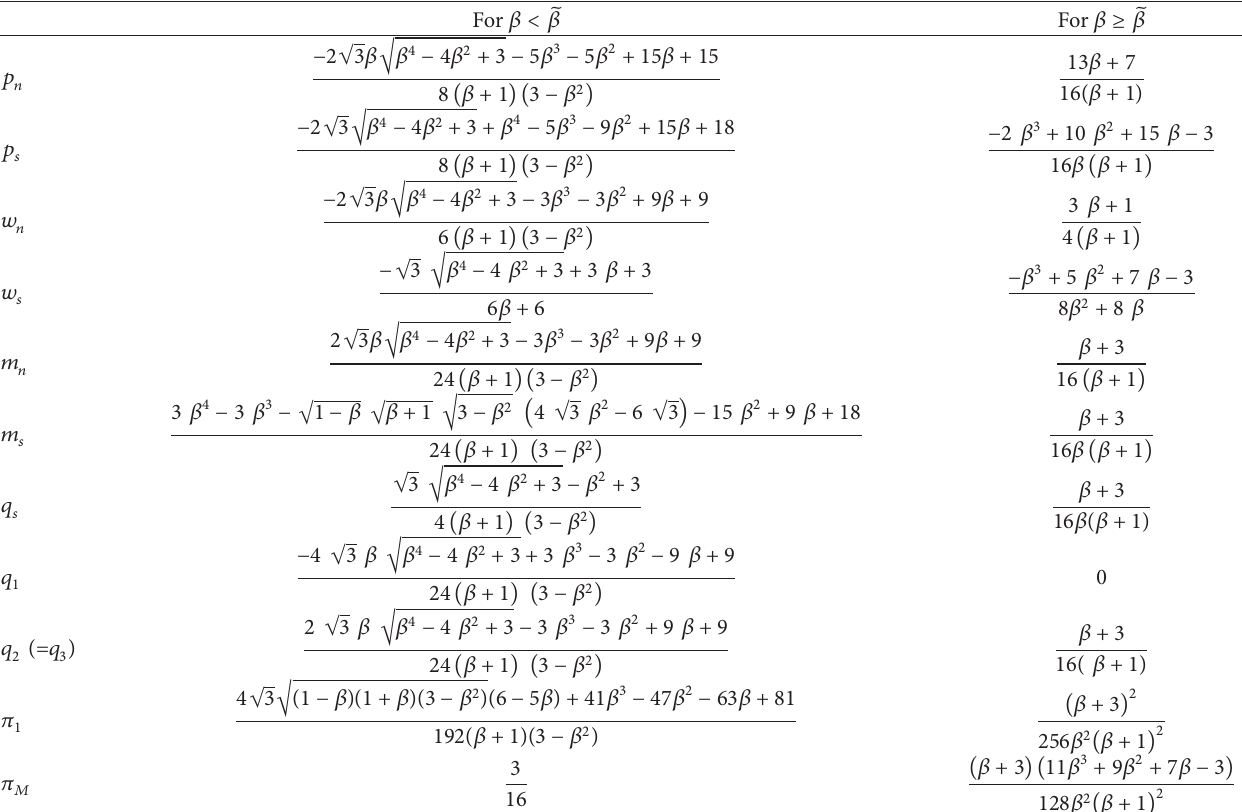
Table 5: Equilibrium outcome under ARM scenario with assortment